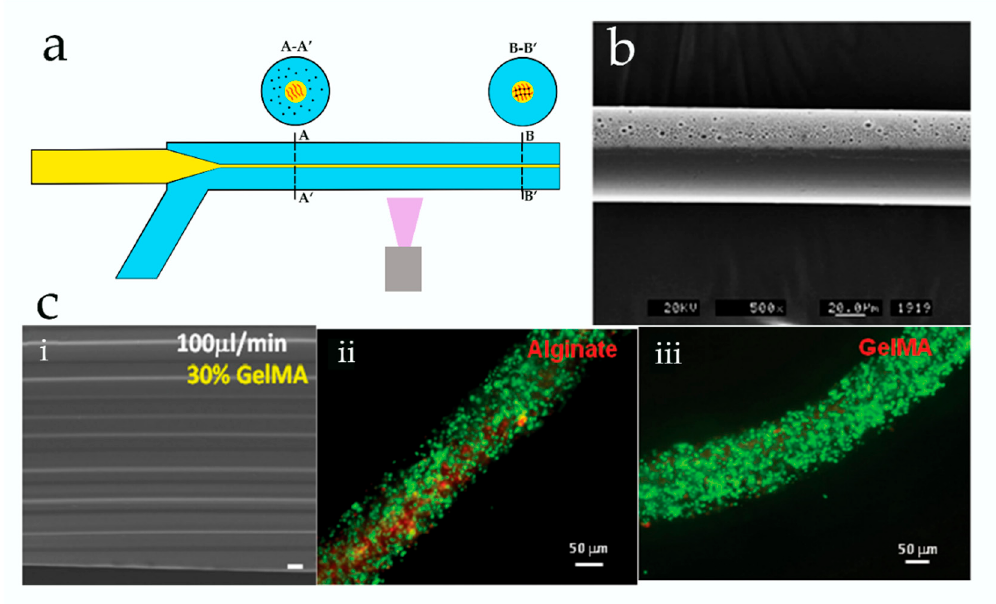
Figure 3. Photopolymerization combined with microfluidics spinning methods used to fabricate microfibers. ( a ) Three-dimensional microfluidic hydrodynamic device used to prepare solid microfibers with photopolymerization method; ( b ) Janus microfibers fabricated by photopolymerization in microfluidic device (reprinted with permission from [54]); ( c ) flat microfibers with a grooved surface prepared by microfluidic spinning; ( i ) scanning electron microscop image, scale bar 20 µ m; ( ii , iii ) fluorescence images cultured on alginate fibers; ( ii ) and methacrylamide-modified gelatin (GelMA) fibers; ( iii ) (reprinted with permission from [55]).